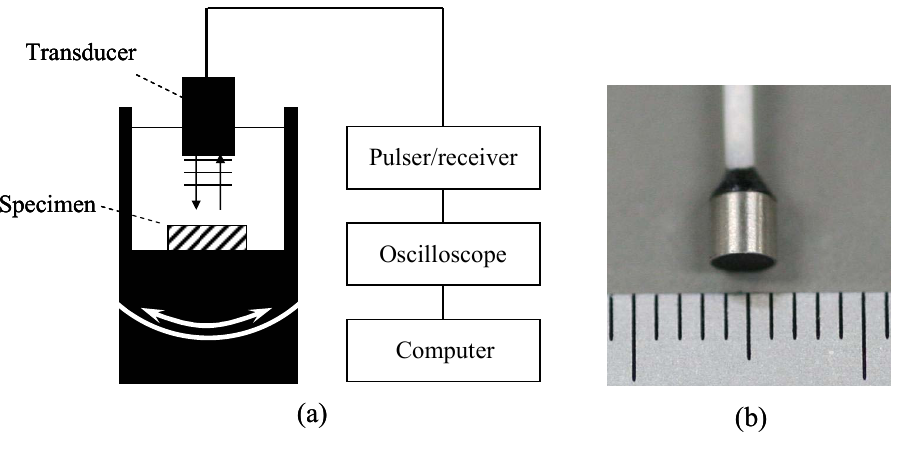
Figure 1: (a) Schematic drawing of the ultrasound measurement system. A small transducer was fixed over the measurement device. The measurement was performed in water at room temperature and the A-mode echogram was measured. (b) Ultrasound transducer (diameter: 2mm, frequency: